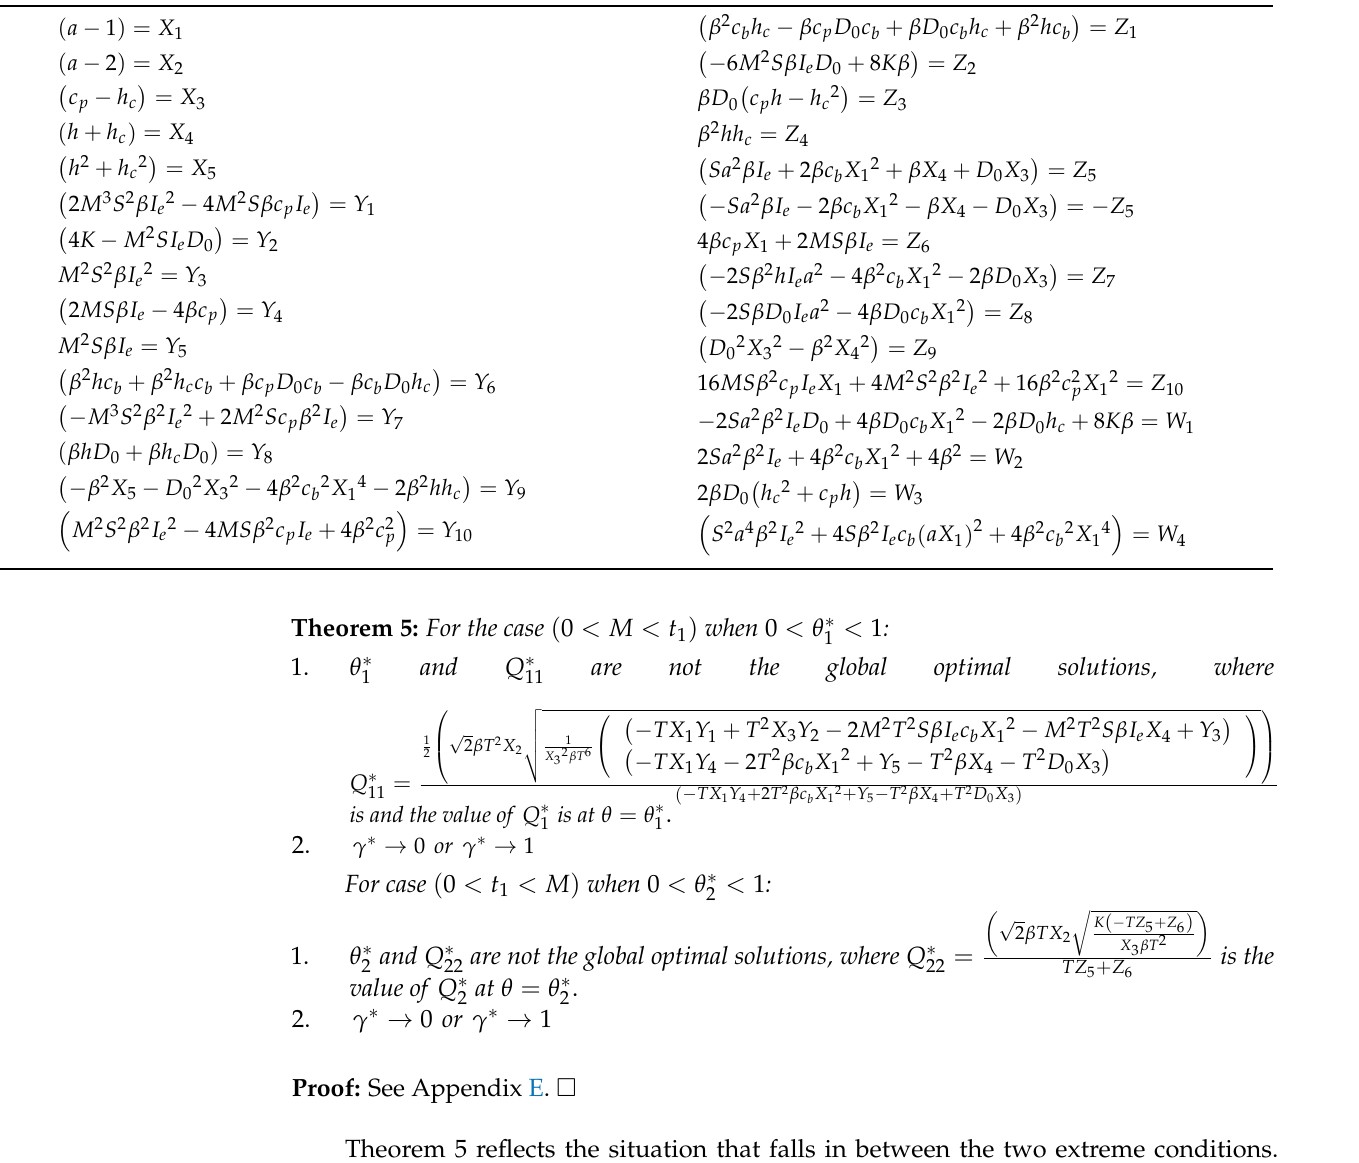
Table 3. Values of X's, Y's, Z's, and